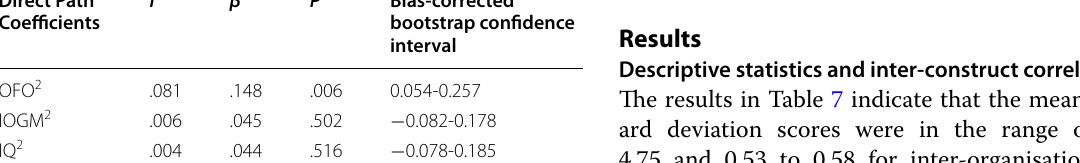
Table 6 Non-linearity effect results Direct Path